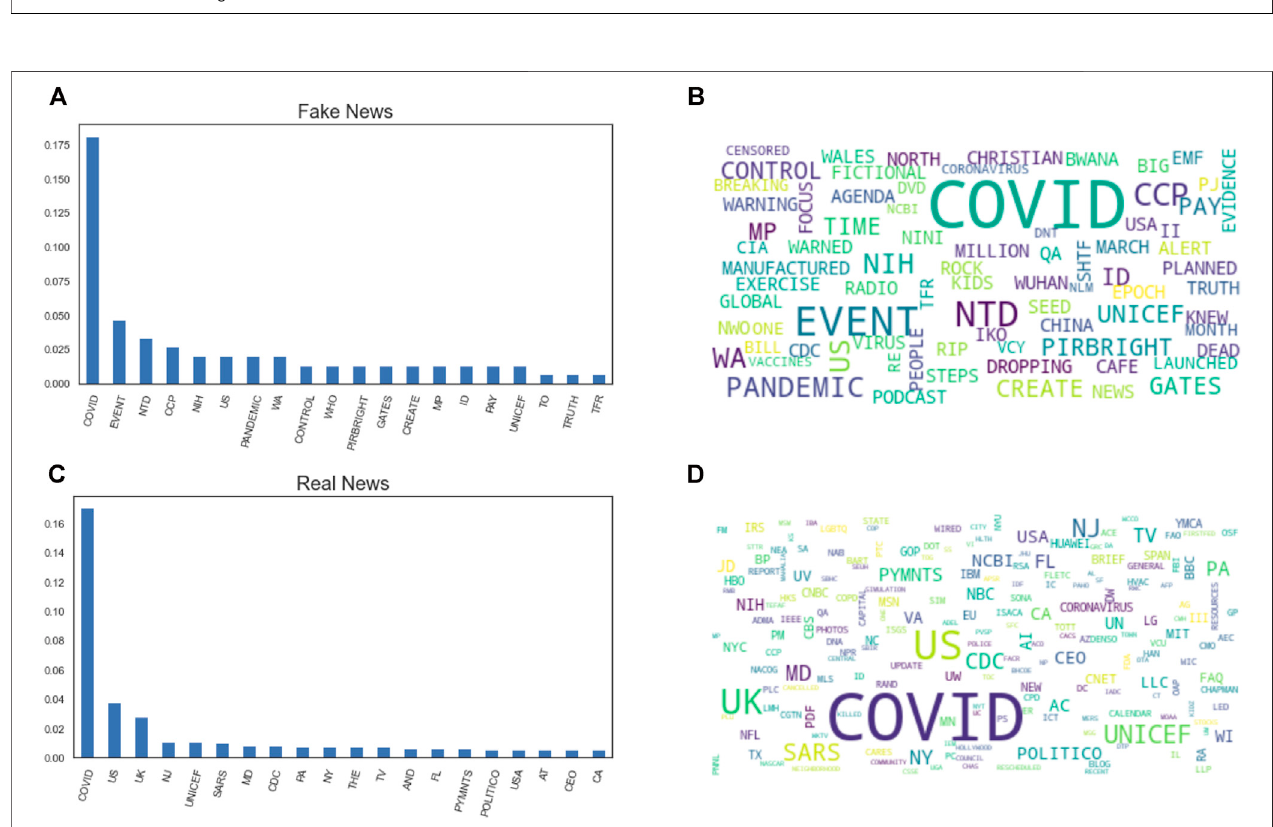
FIGURE 4 | The 20 mostly used uppercase words in fake news (A) and real news (C) datasets. In panels (B) and (D) , respectively, the word clouds show words sized according to their weights in the datasets. The use of uppercase words is different between the two datasets: in real news, the use of uppercase words is more frequent to indicate acronyms, brands, and organisations, while in fake news, uppercase words emphasise feelings, alerts, and potential warnings.